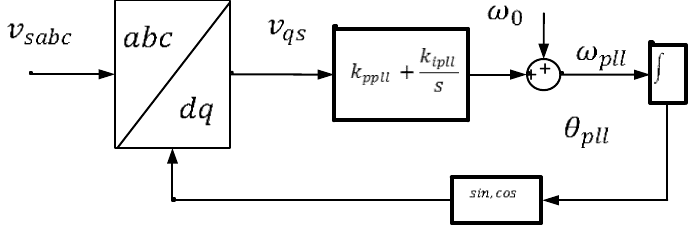
Figure 6. Rotor ‐ side converter controller block.